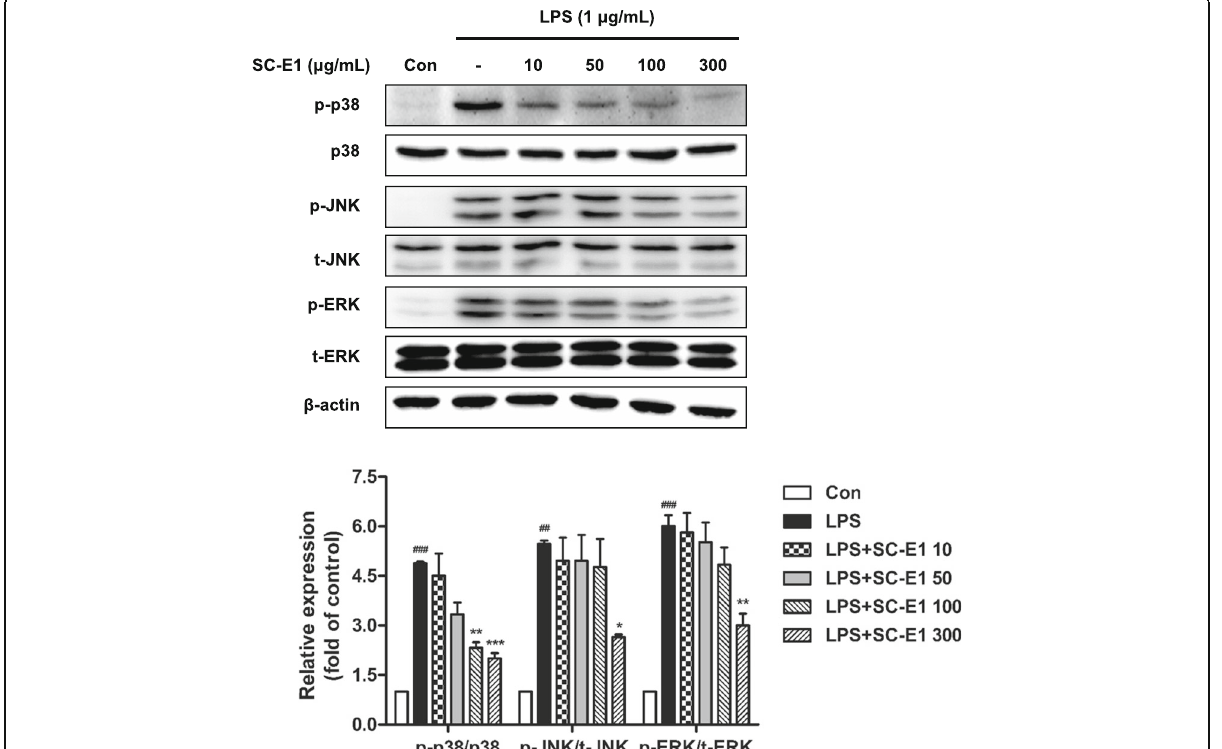
Fig. 5 Effects of SC-E1 on the MAPK pathway activation in LPS-stimulated RAW 264.7 macrophages. The activation of the ERK, JNK, and p38 protein was detected by immunoblotting. Each experiment conducted for 3 repeats per conditions. (Significant compared to the control, ## p < 0.01 and ### p < 0.001, significant compared to LPS alone, * p < 0.05, ** p < 0.01, and *** p <